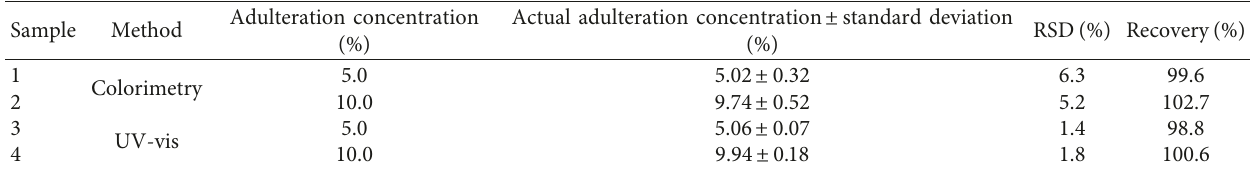
Table 1: The concentration of adulterants in mixtures containing AuNPs was determined by colorimetry, and the results were verified by